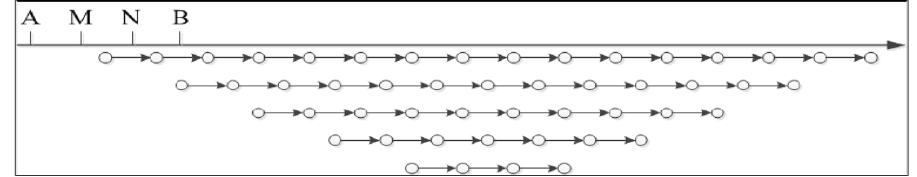
Figure 3. Sketch of data acquisition for Winner